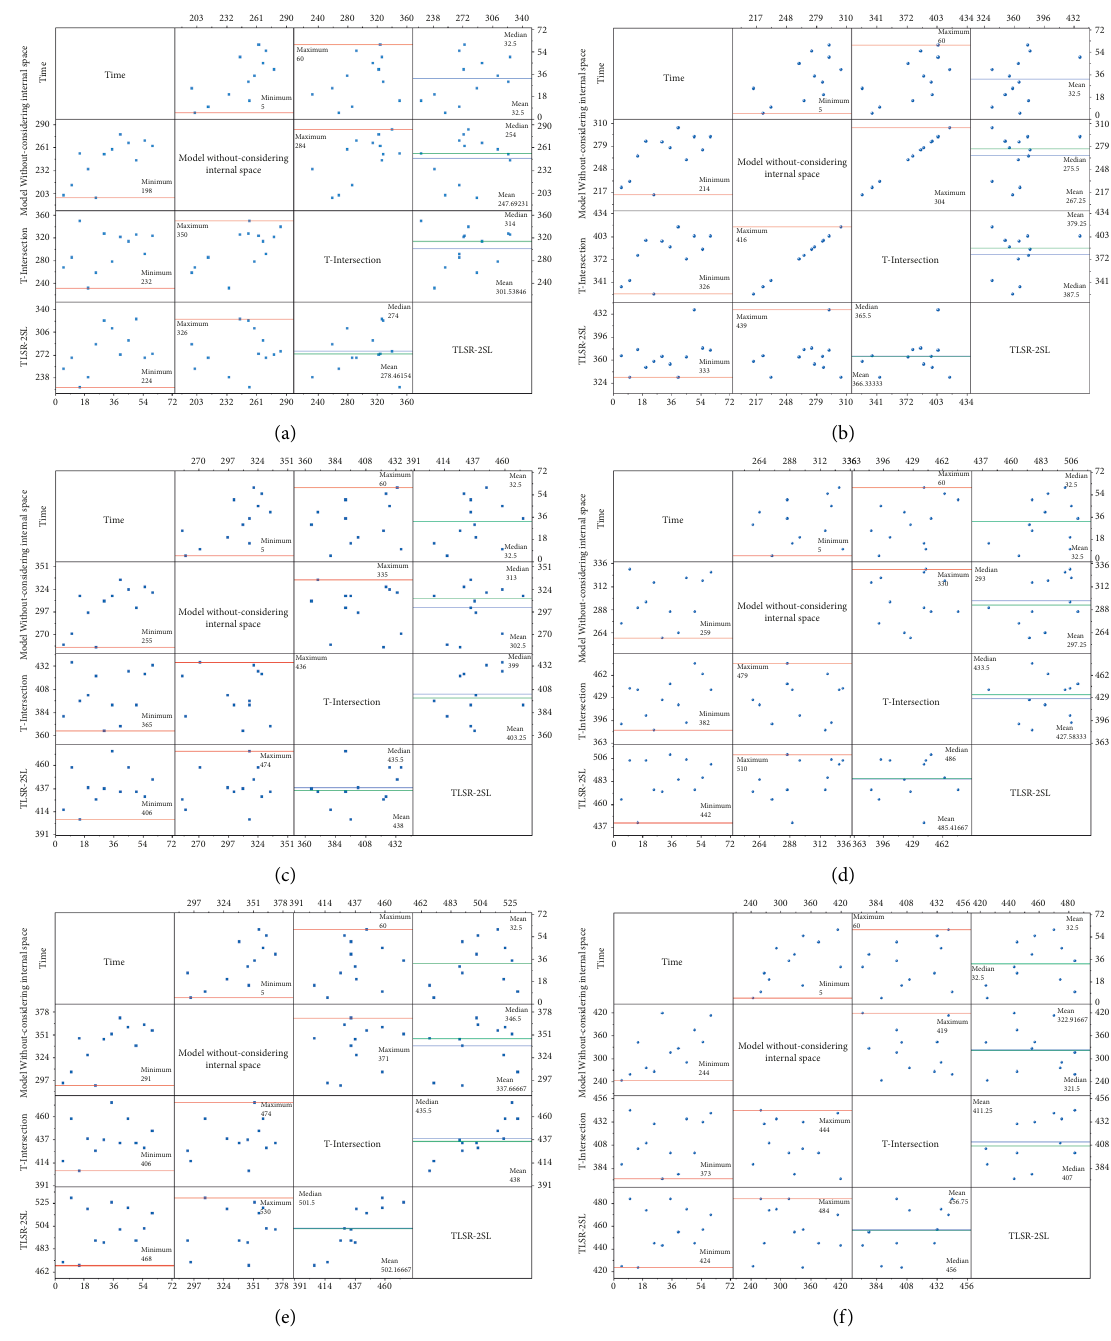
Figure 7: E-S flow under [60 s ∼ 160s] signal cycle with 5% proportion of heavy vehicles. (a) 60s signal cycle with 10m radius. (b) 80s signal cycle with 20 m radius. (c) 100s signal cycle with 30m radius (d) 120s signal cycle with 40m radius. (e) 140s signal cycle with 50m radius. (f) 160s signal cycle with 60m